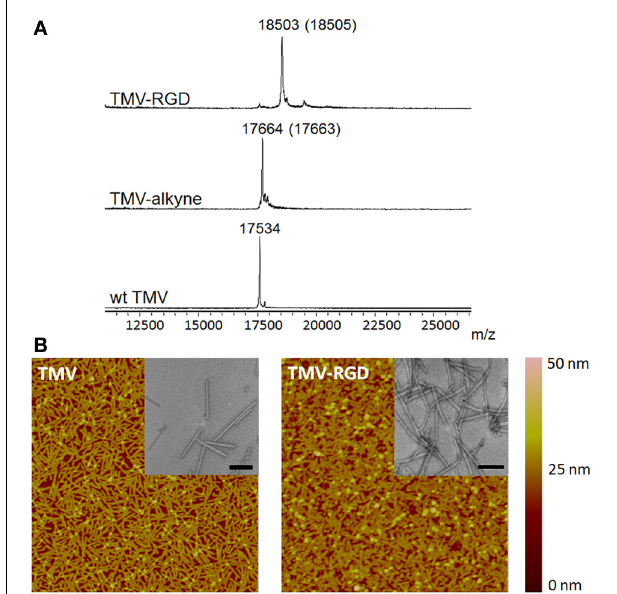
FIGURE 2 | Characterization of TMV particles. (A) MALDI-TOF MS spectra of the subunit protein of wild type TMV (17534m/z), TMV-alkyne (17664m/z), and the CuAAC reaction product TMV-RGD (18503m/z). The numbers in parentheses refer to the theoretical masses. (B) The morphology of TMV particles before (TMV) and after (TMV-RGD) bioconjugation visualized by AFM and TEM (insets). Scan areas of AFM are 5 × 5 μ m; and scale bars of TEM are